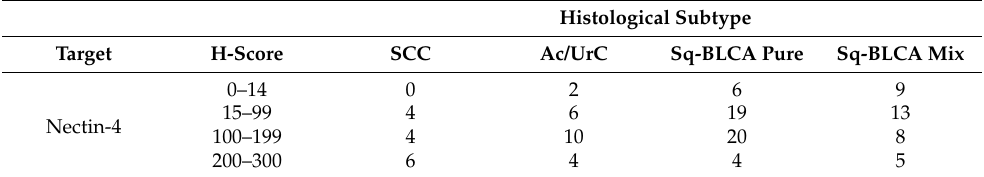
Table 4. Immunohistochemical results of Nectin-4 expression in histological subtypes of bladder